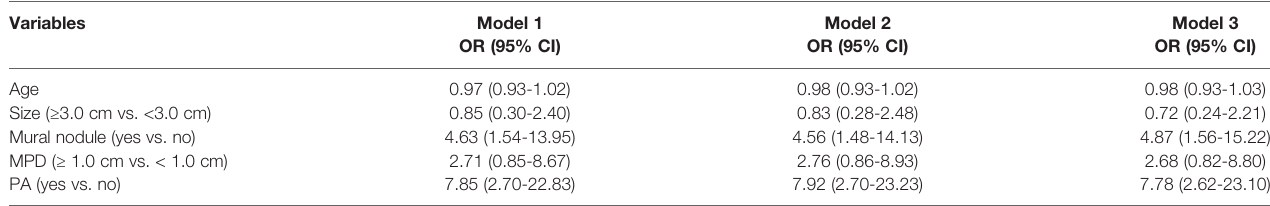
TABLE 3 | Associated factors with invasive carcinoma in IPMN patients.